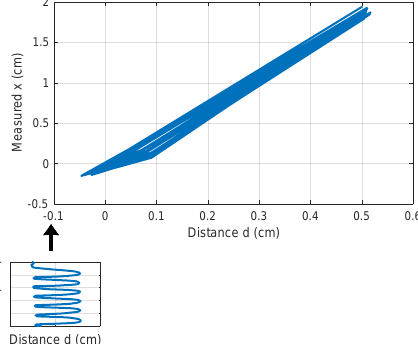
Figure 6. Hall-effect sensor showing hysteresis. The real-time distance, measured by the Hall-effect sensor, differs from the distance d measured by other calibrated measurement